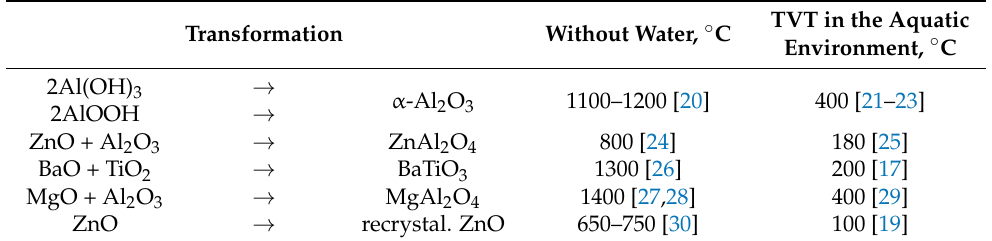
TVT in the Aquatic Environment, ◦ C